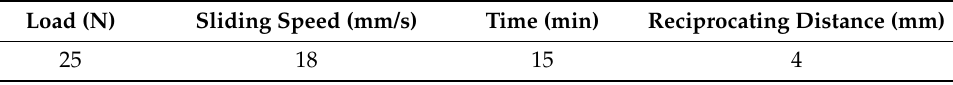
Figure 2. Experimental setup for wear test (UMT-II). Table 3. The wear test